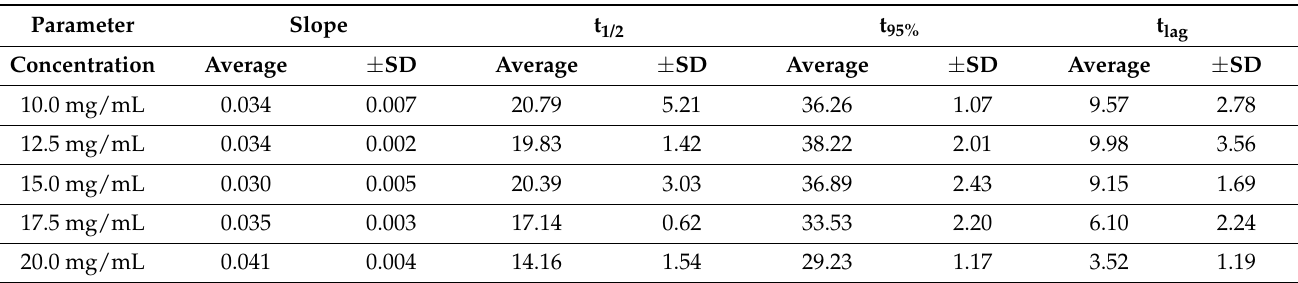
Table 1. Summary of gelation kinetics parameters for dECM hydrogels. Statistical analysis and p -values can be found in Figure S2 in the